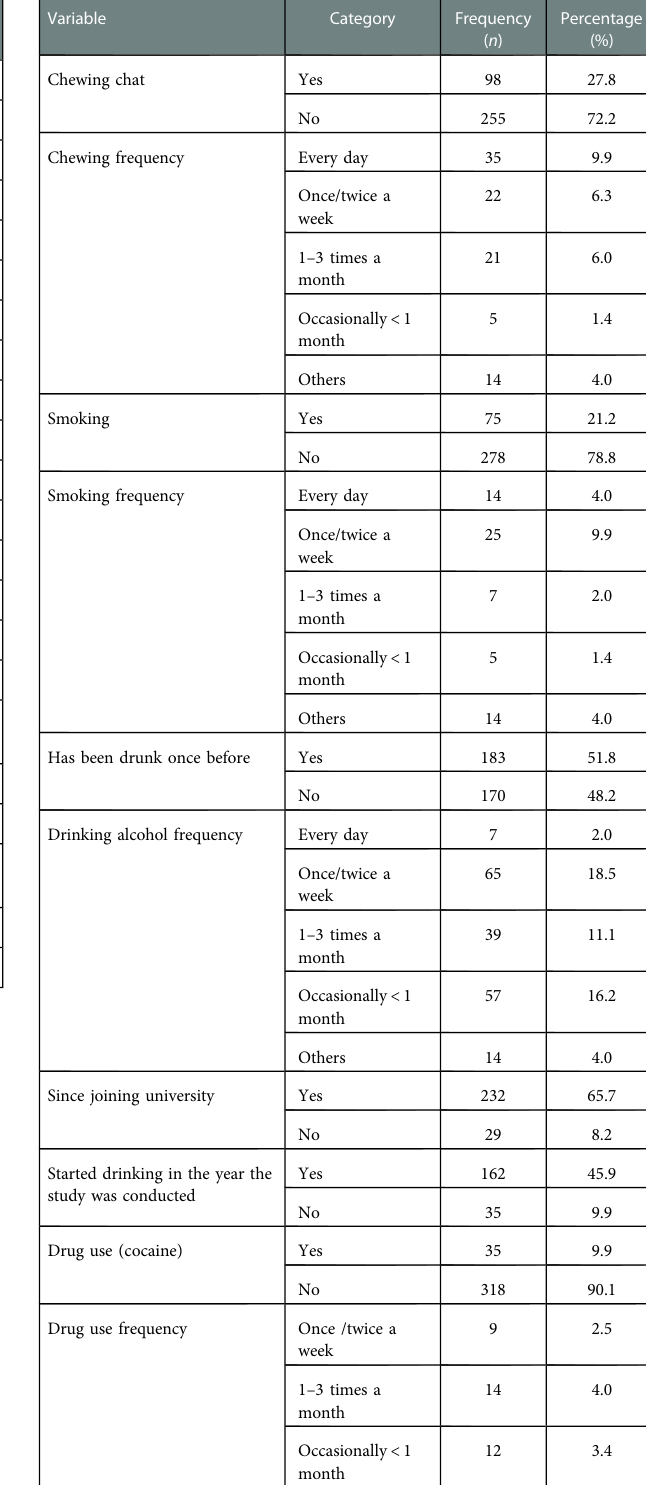
TABLE 1 Socio-demographic characteristics among female Wolkite University students, southwest Ethiopia, 2021 ( n